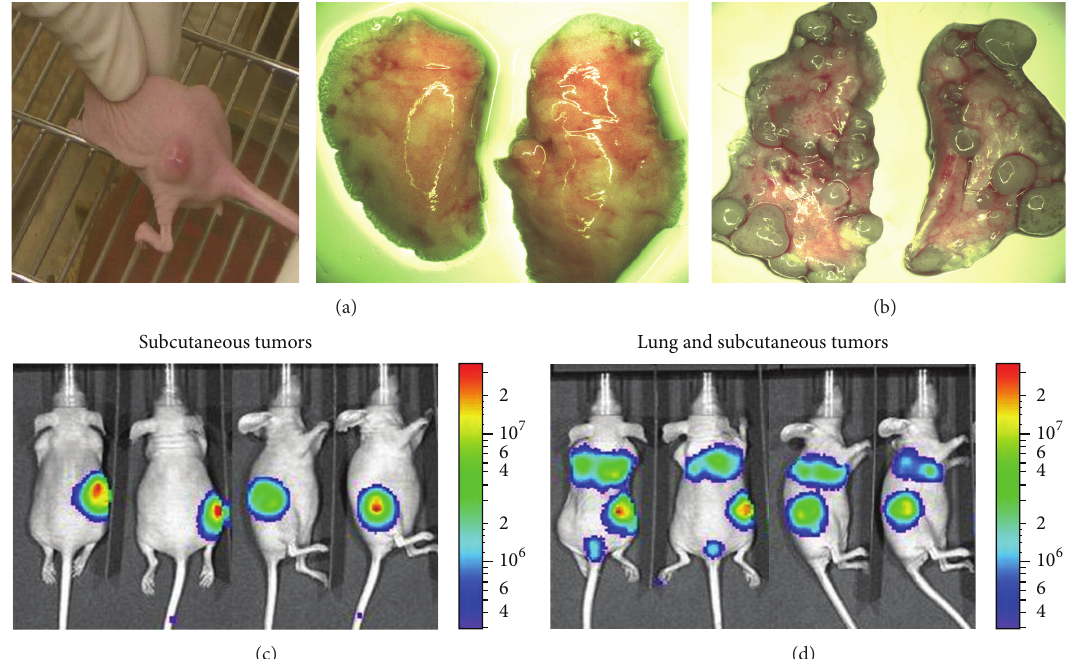
Figure 5: VSV Δ M51 shows tumor-specific replication after its systemic delivery in nude mice harboring subcutaneous and lung tumors. In one group (a), a solid tumor mass developed in the hind-foot region a week after the subcutaneous inoculation of EWS cells. No tumor nodules were noted on gross inspection of the lungs (a). The second cohort of mice (d) was inoculated with EWS both subcutaneously and intravenously. Numerous tumor nodules were noted bilaterally on gross inspection of the lungs (b). After tumor growth in both groups, VSV Δ M51-Luc was administered intravenously. At 72 h after treatment, In vivo Imaging System (IVIS) was used to assess viral replication in live animals. The luciferase signal is noted only at the tumor site in both groups